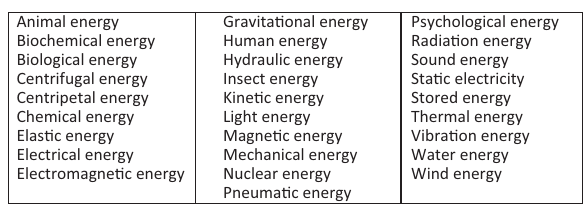
FIGURE 2: Basic manifestations and configurations of